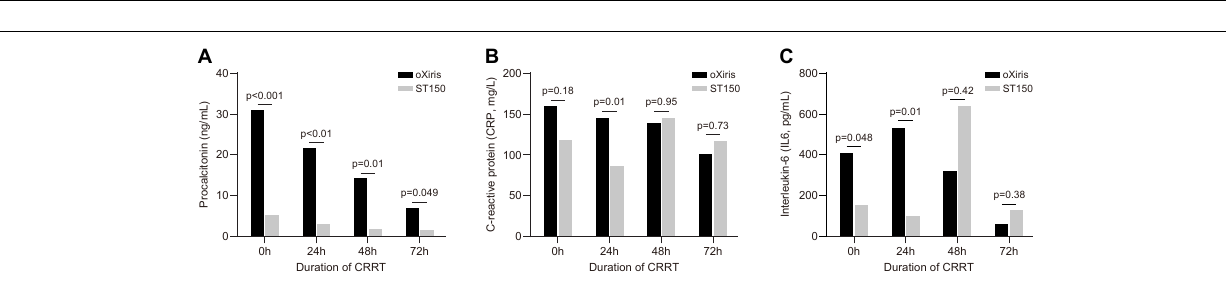
FIGURE 3 | The Reduction of SOFA and VIS score in treatment period (0–72 h) in the oXiris filter groups and ST150 groups. Panel (A) shows the median at Reduction of SOFA each time point and Panel (B) shows the median change reduction of VIS.